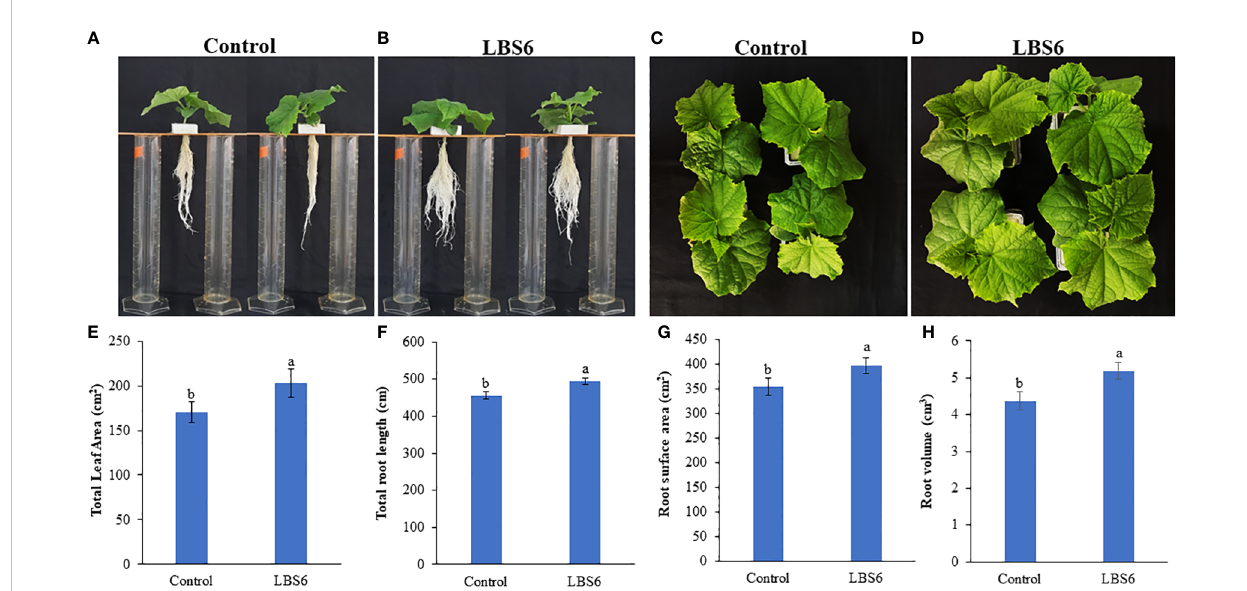
FIGURE 9 Kappaphycus alvarezii based extract (LBS6) improved the growth of cucumber plants. Twenty eight day old plants sprayed with (A, C) water (Control), and (B, D) LBS6. Here the effects of LBS6 on (E) total leaf area, (F) total root length, (G) root surface area, and (H) root volume of cucumber plants are shown. The values were presented as mean ± SE and means represented by the same letters were not signi fi cantly different at p ≤ 0.01. Each experiment was carried out in triplicate, and each experimental unit had ten plants (n =